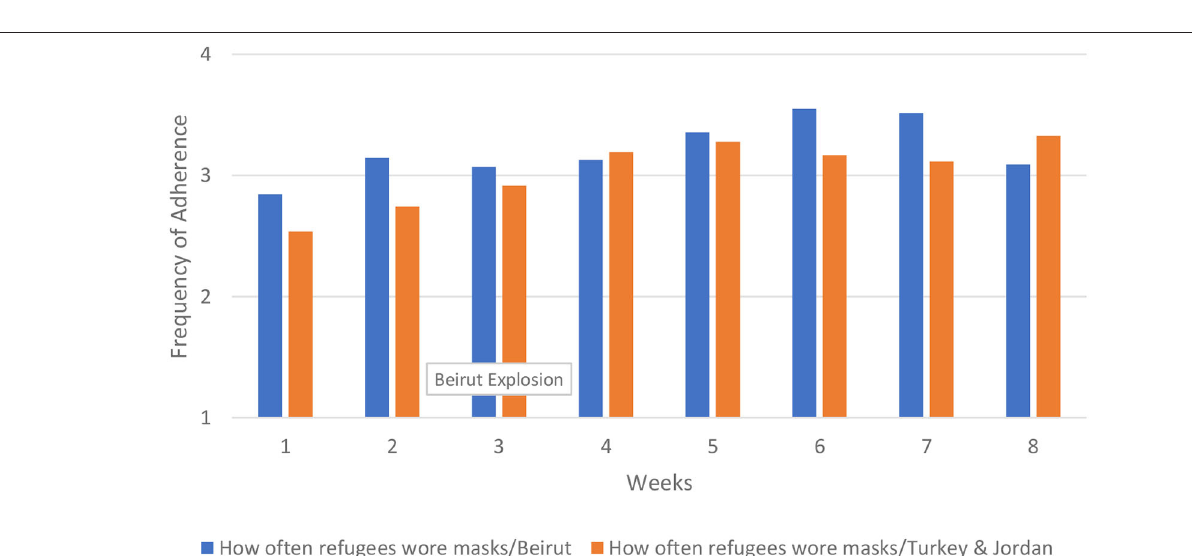
FIGURE 8 | How often refugees wore